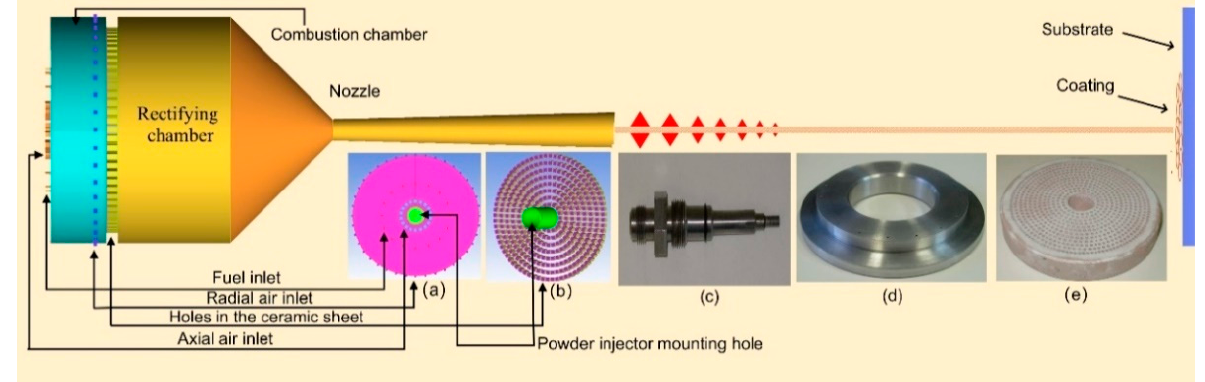
Figure 1. Structural schematic of the activated combustion high-velocity air-fuel (AC-HVAF) spray gun model and the spraying principle: ( a ) left view of the spray gun; ( b ) ceramic sheet and powder injector mounting hole; ( c ) powder injector of actual spray gun; ( d ) propane distributor of actual spray gun; ( e ) porous ceramic sheet of actual spray gun.